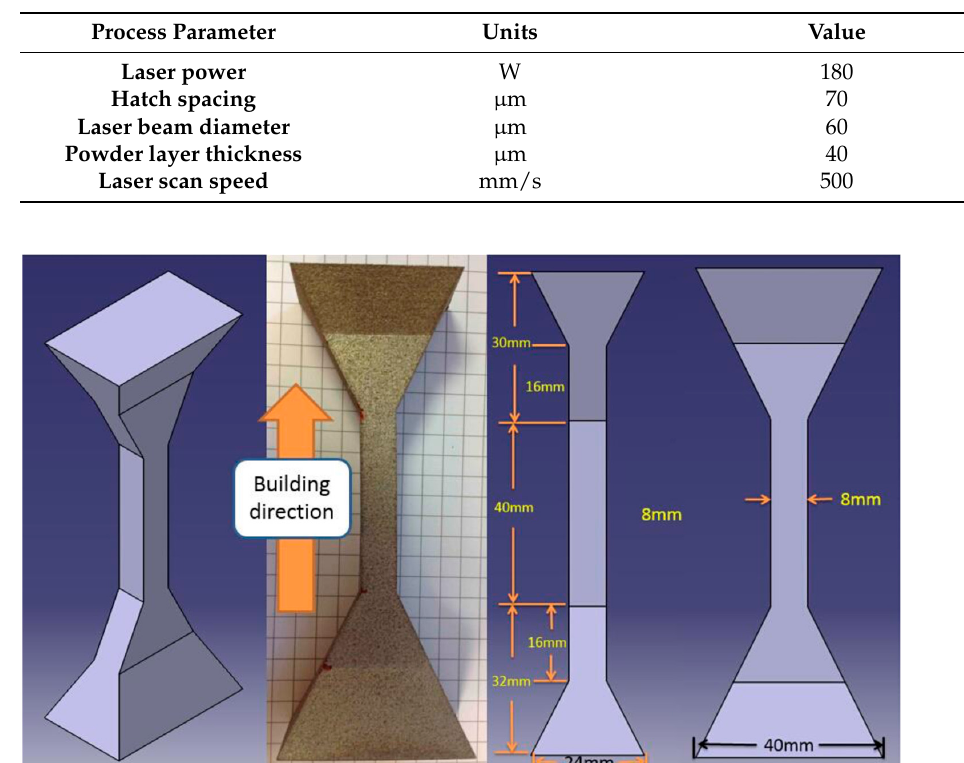
Figure 1. Sample geometry of the 316 L stainless steel test peg with dimensions.